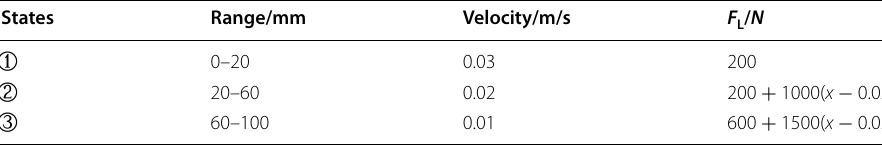
Table 1 Simulation parameters